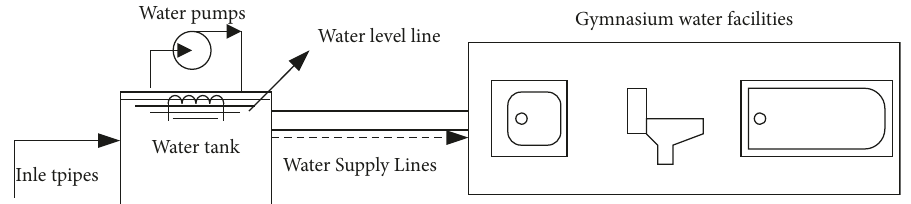
Figure 1: Basic process of hot water supply in stadiums.